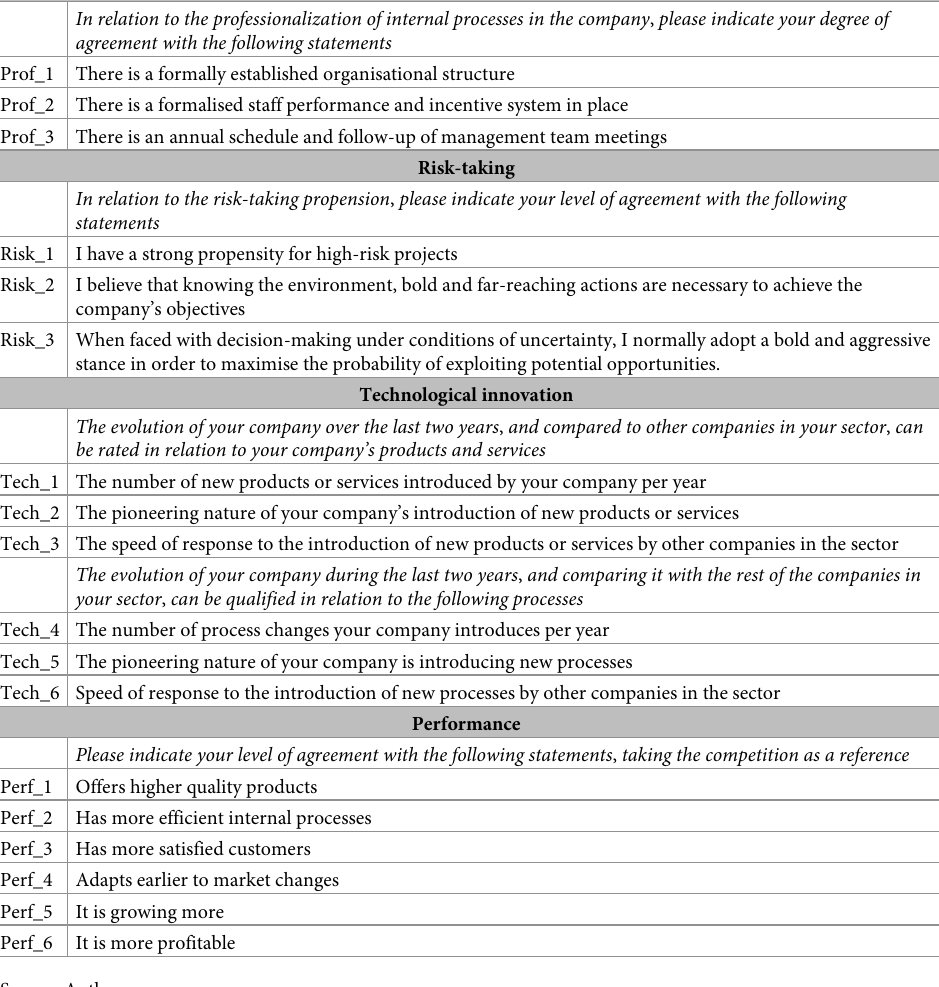
Table 2. Variables used in the